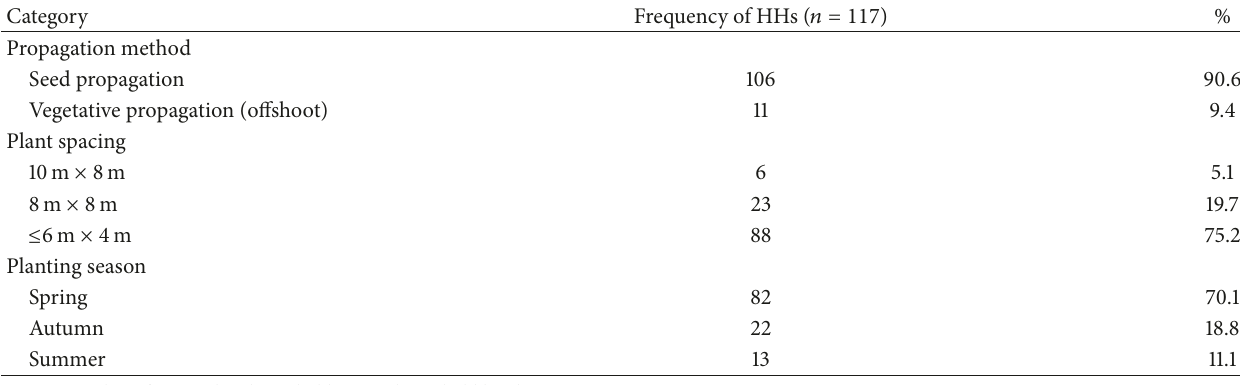
Table 4: Propagation methods, spacing, and planting season of date palm in the study area.